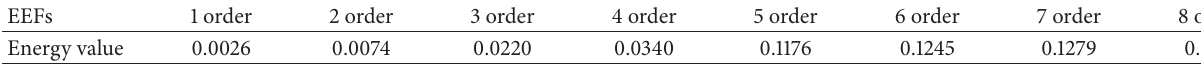
Table 1: Energy value of the dynamical systems based on EEFs.